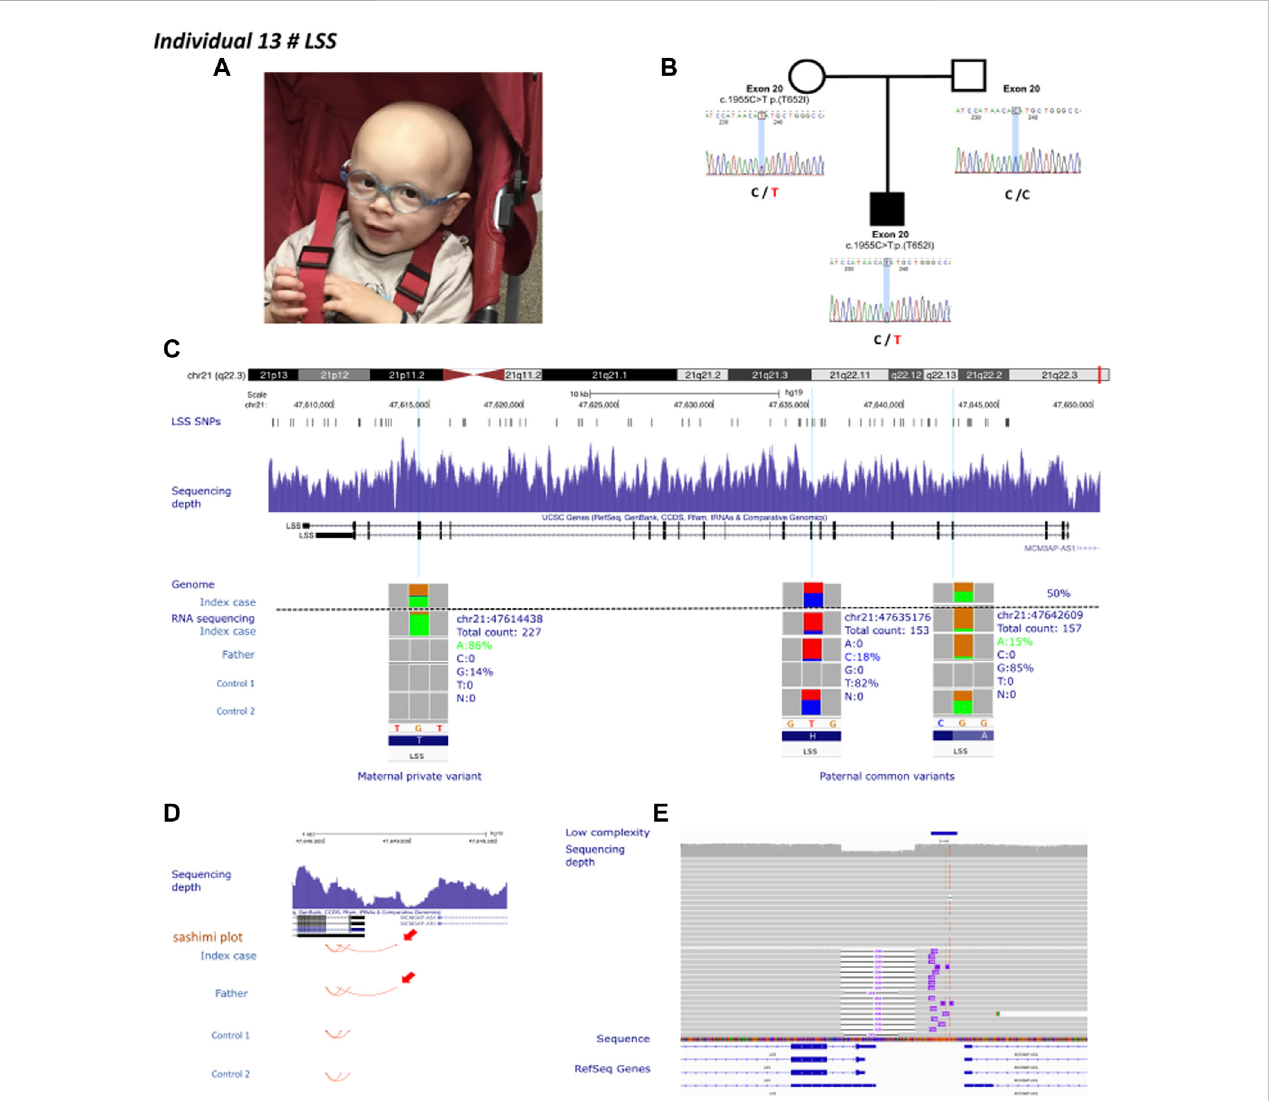
FIGURE 4 Individual 13 — Alopecia-intellectual disabilitysyndrome4,MIM 618840. (A) Dysmorphic featuresshowingalopeciauniversalis. (B) Pedigreesofindividual 13. The known maternally inherited LSS pathogenic variant was Sanger sequenced. LSS pathogenic variants are highlighted in red. (C) Ideogram showing chromosome 21 and LSS localization. UCSC genome browser snapshot with visualization of LSS SNPs, sequencing depth, and genome and RNA-sequencing allelic balance from IGV (integrative genomics viewer) of three variants, one private maternal variant and two common paternal variants in individual 13, his father and two healthy controls, con fi rming monoallelic expression of the maternal allele in individual 13. (D) Visualization of the promoter region of LSS . Red arrows show aberrant splicing within the intron 1 of LSS and the intergenic region between LSS and MCM3AP in individual 13 and his father. (E) IGV visualization of long-read Oxford Nanopore genome sequencing showing the sequencing depth and a heterozygous deletion affecting the promoter region of